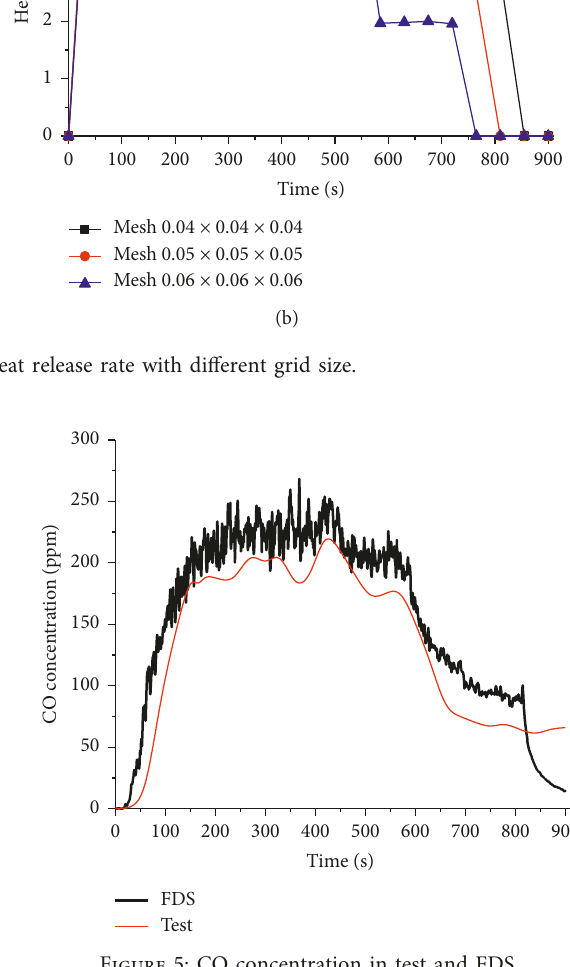
Figure 4: Temperature result in test and FDS.